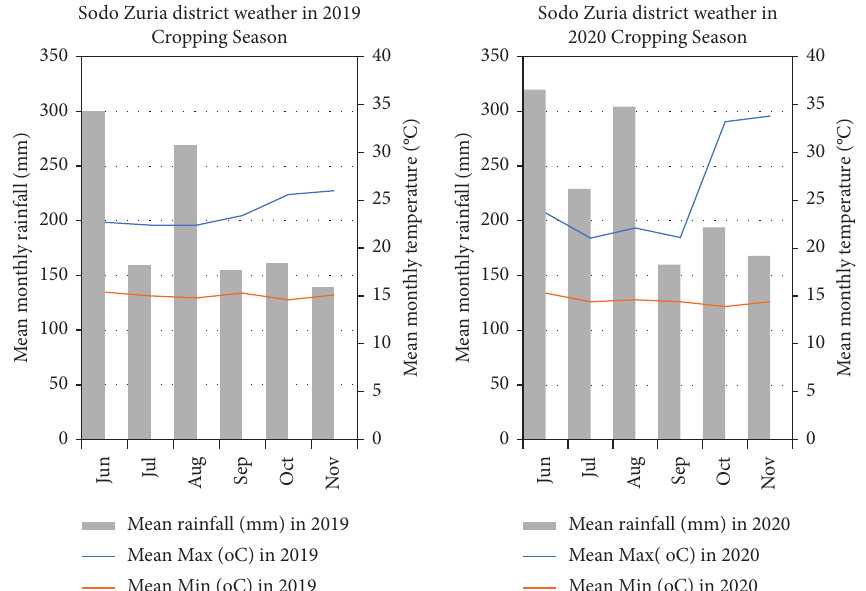
Figure 2: Monthly total rainfall and average maximum and minimum air temperatures in 2019 and 2020 growing seasons in Sodo Zuria District (National Meteorological Agency,